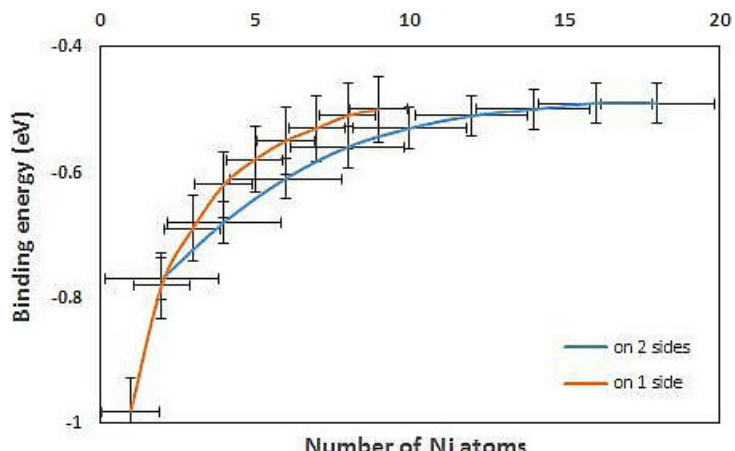
Fig. 6. The binding energy of a single Ni atom as a function of the number of Ni